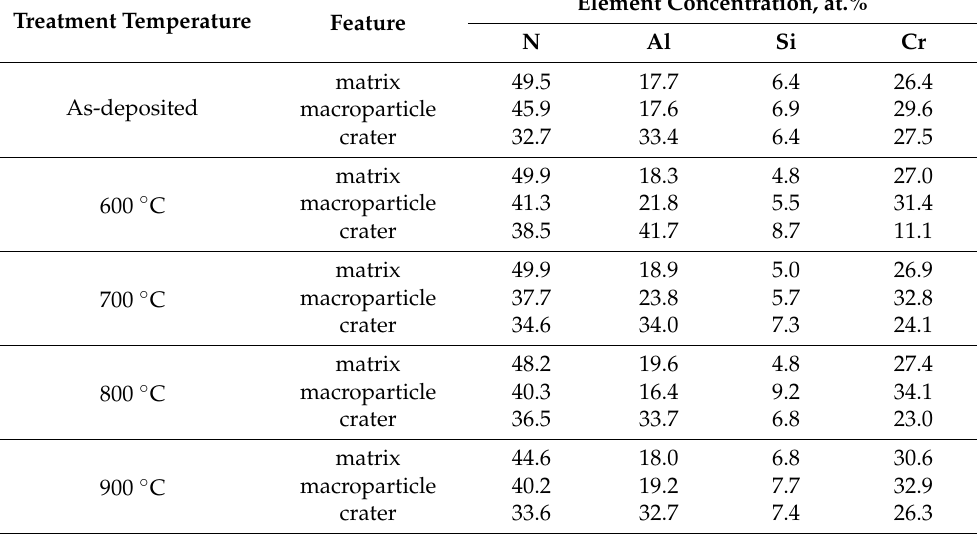
Table 1. Element composition of the main surface features of modulated CrAlSiN-AlSiN coating. Treatment